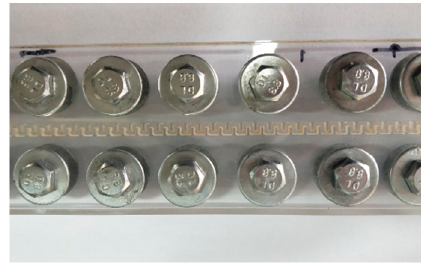
Figure 2. Physical model of A emitter.